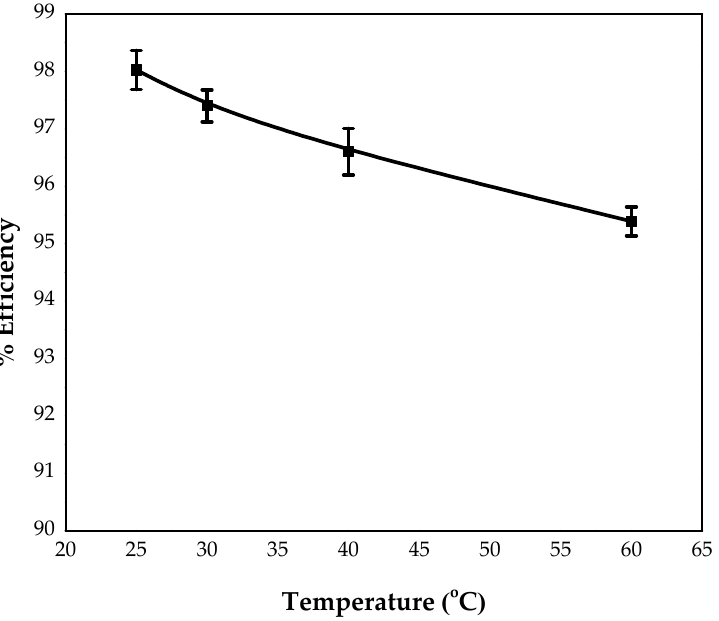
Figure 10. Effect of temperature on alizarin extraction by DES-3 (initial concentration of alizarin = 1000 mg/L, pH = 6.37, contact time = 5 min and DES dosage = 0.15 mL).